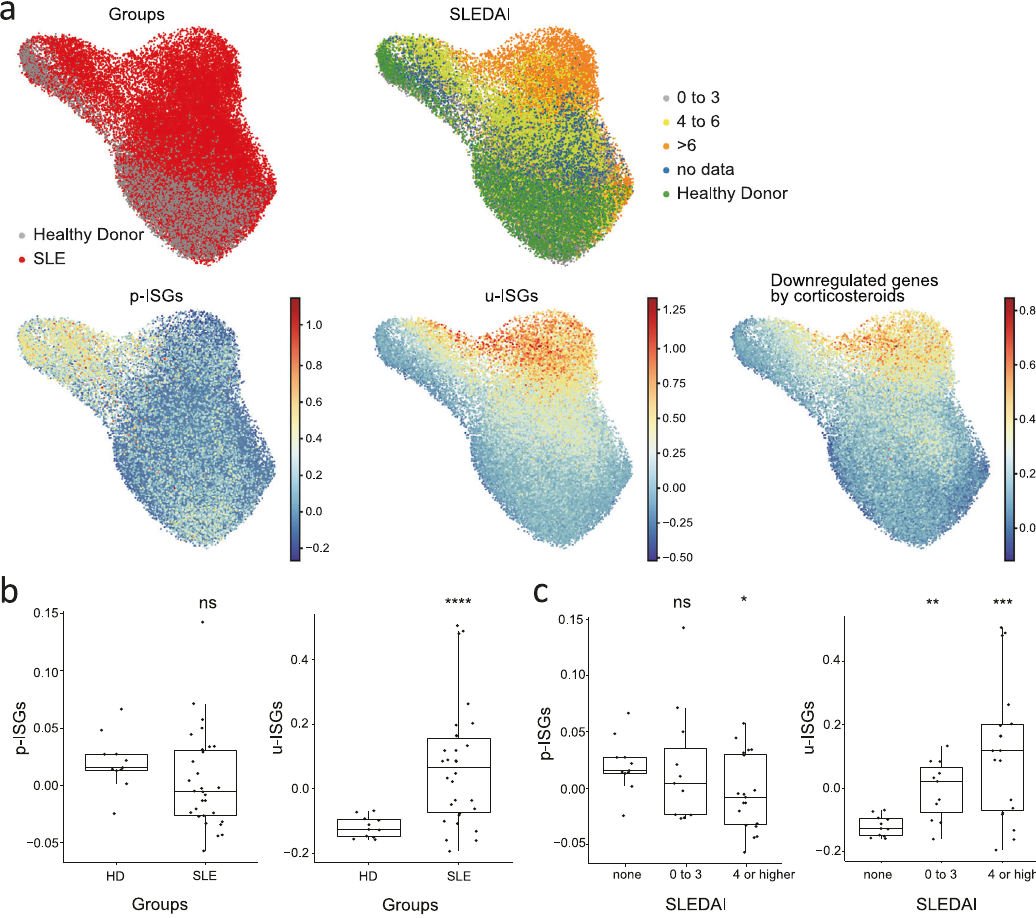
Fig. 5 Transcriptomic features of monocytes from lupus patients are associated with u-ISGs and genes downregulated by corticosteroid treatment. a UMAP plot of monocyte subclusters originating from publicly available single-cell transcriptome data 36 showing the expression patterns of p-ISGs, u-ISGs and downregulated genes after corticosteroid treatment. b Box-and-whisker plots of the different expression levels of p-ISGs and u-ISGs between healthy donors and lupus patients. c Box-and-whisker plots of the different expression levels of p-ISGs and u-ISGs among healthy donors (none) and patients with an SLE disease activity index (SLEDAI) of 0 to 3 or ≥ 4. The box of each boxplot starts in the fi rst quartile and ends in the third, with the line inside representing the